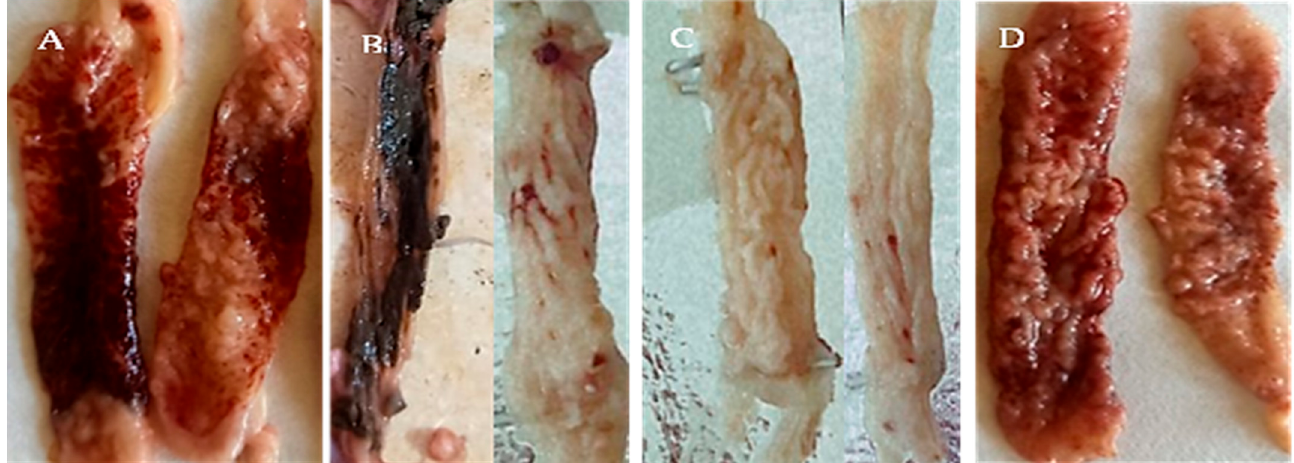
Figure 4. Gross pathological findings in the ceca of E-infected 3-week-old coccidia-free chickens (7 days after infection) tenella oocysts sporulated in various solutions. ( A ) Lesion score + 4 was caused by E. tenella oocysts that sporulated in 2.5% K2Cr2O7, revealing a sheet of coagulated blood covering the mucosa, complete loss of cecal corrugations, and ulceration. ( B ) Lesion score +1 induced by E. tenella oocysts sporulated in allicin (90 mg/mL) solutions; slight thickening of the cecal wall; cecal contents are relatively normal. ( C ) Lesion score +2 was induced by E. tenella oocysts that sporulated in an alcoholic garlic extract (180 mg/mL) solution, revealing a moderately thick cecal wall, scattered patechae on the mucosal surface, and tenacious cecal contents. ( D ) Lesion score +3 induced by E. tenella oocysts which sporulated in KOH 5%; ceca had a markedly thickened wall, eroded mucosal surface, and bloody cecal contents.